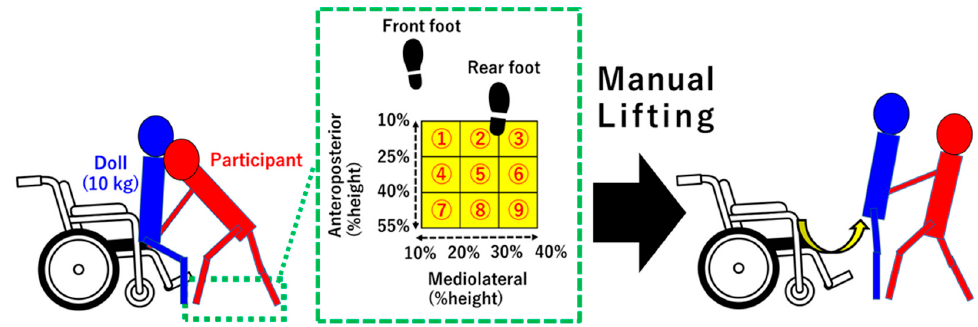
Table 1. Foot distances of the nine foot positions during manual lifting.